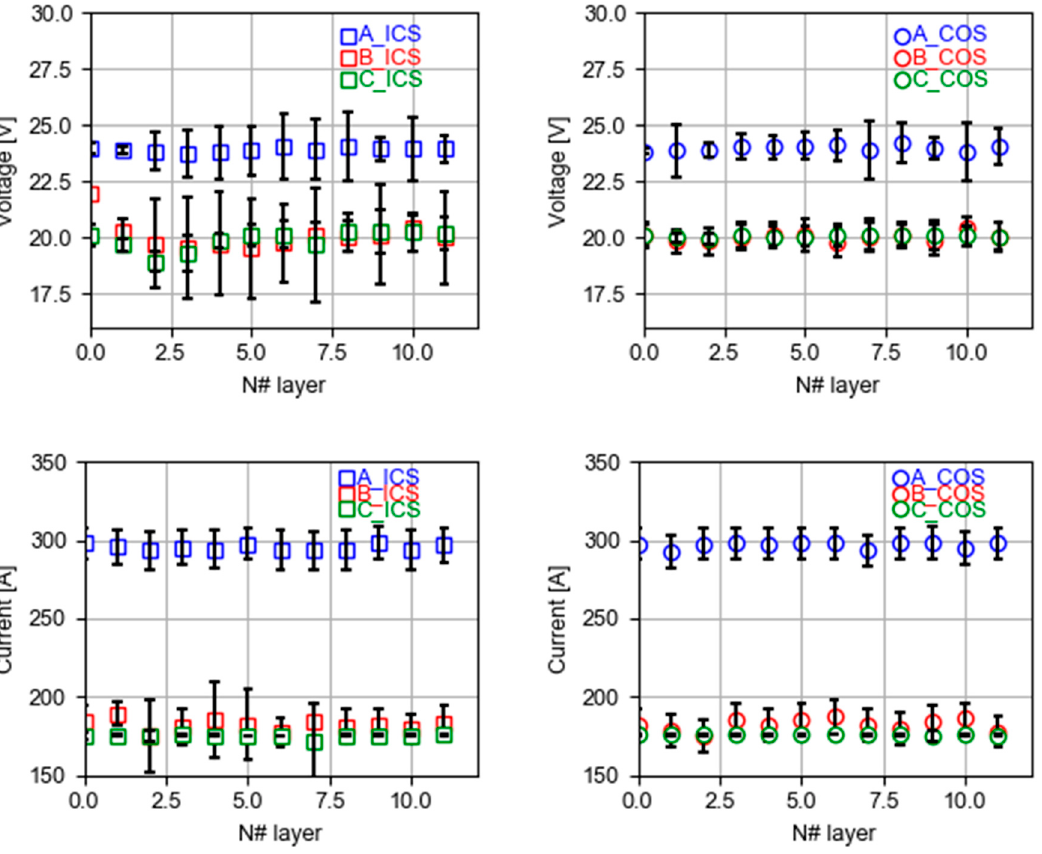
Figure 7. Mean and standard deviation of the current and voltage on the different adding conditions and cooling strategies .